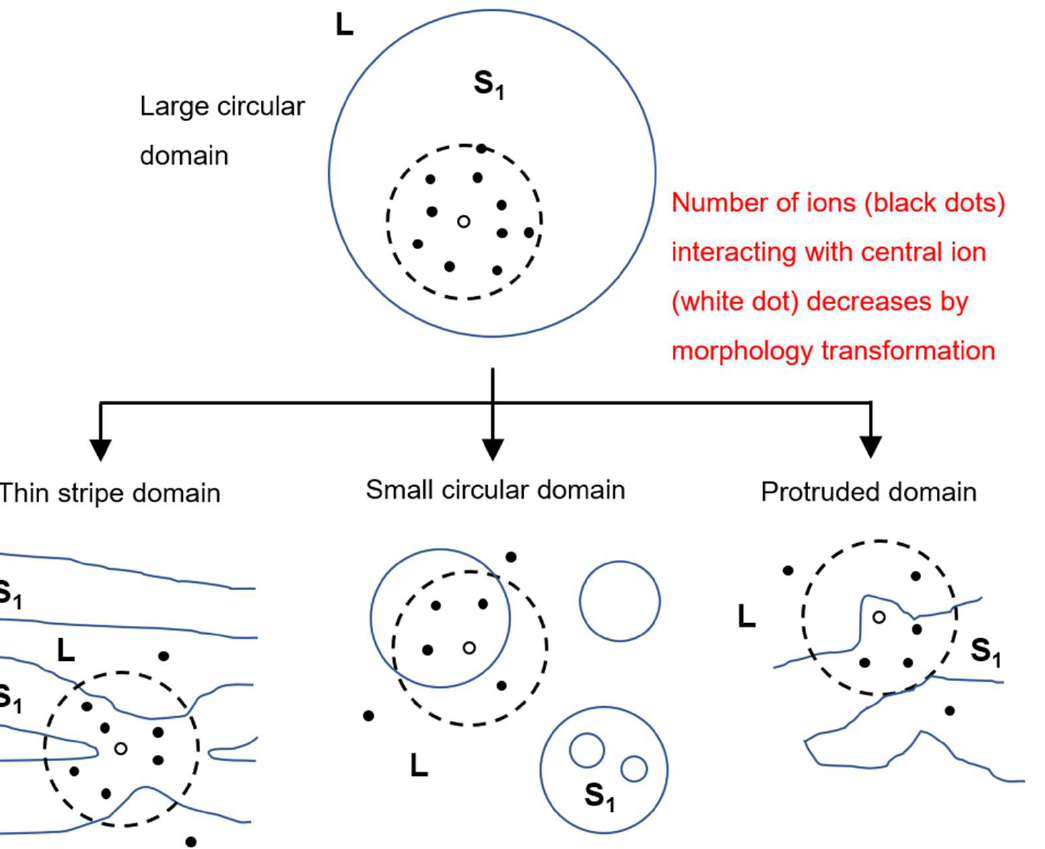
Figure 6. Schematic diagrams of dipole repulsion exerted on an arbitrary surfactant ion (open circle) from other surfactant ions (filled circles) in the interaction range (dotted circle). Transformation from a large circular domain into thin-striped, small, circular or protruded domains reduces the number of dipoles in the interaction range.